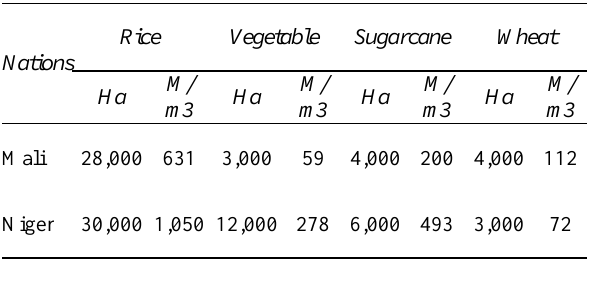
Table 2.4: The use of water for certain agricultural crops in the Region - Water Consumption by the thirstiest crops in the Niger Basin River